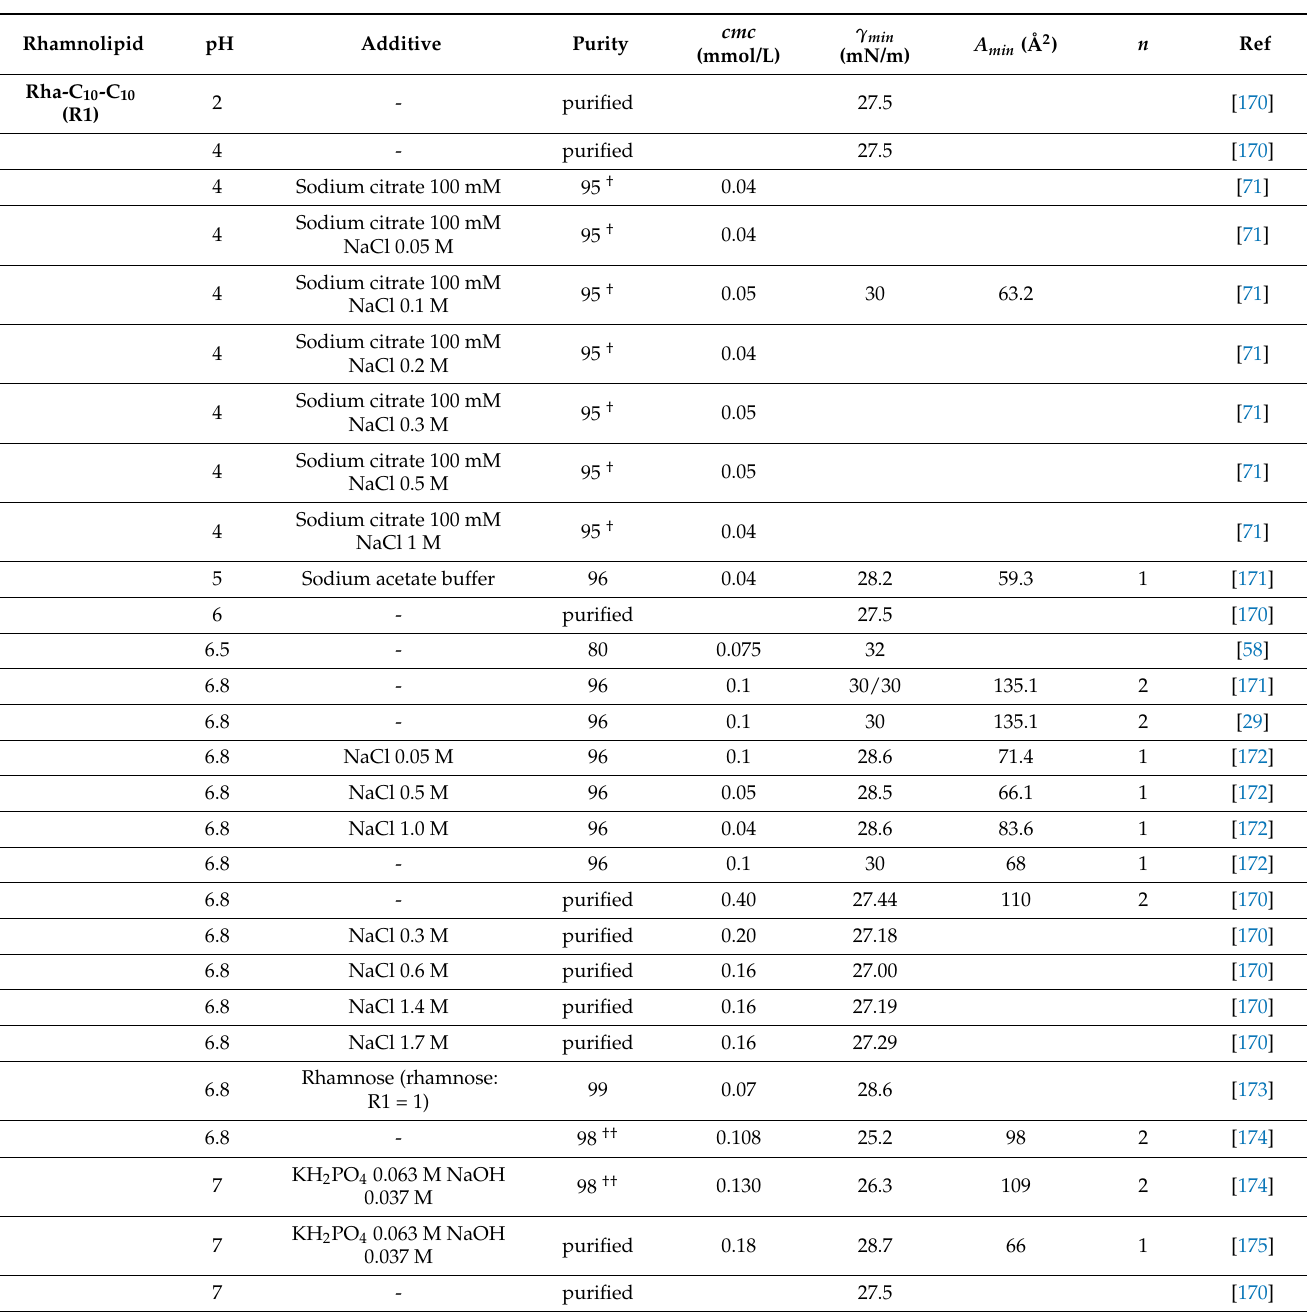
Table 3. The cmc and surface properties of “pure” rhamnolipids (obtained either via purification of microbial extracts or via modified biosynthetic routes) and synthetic rhamnolipids. According to the rhamnolipid pKa = 5.5, rhamnolipids are expected to be neutral at pH < 5.5 and negatively charged at pH >